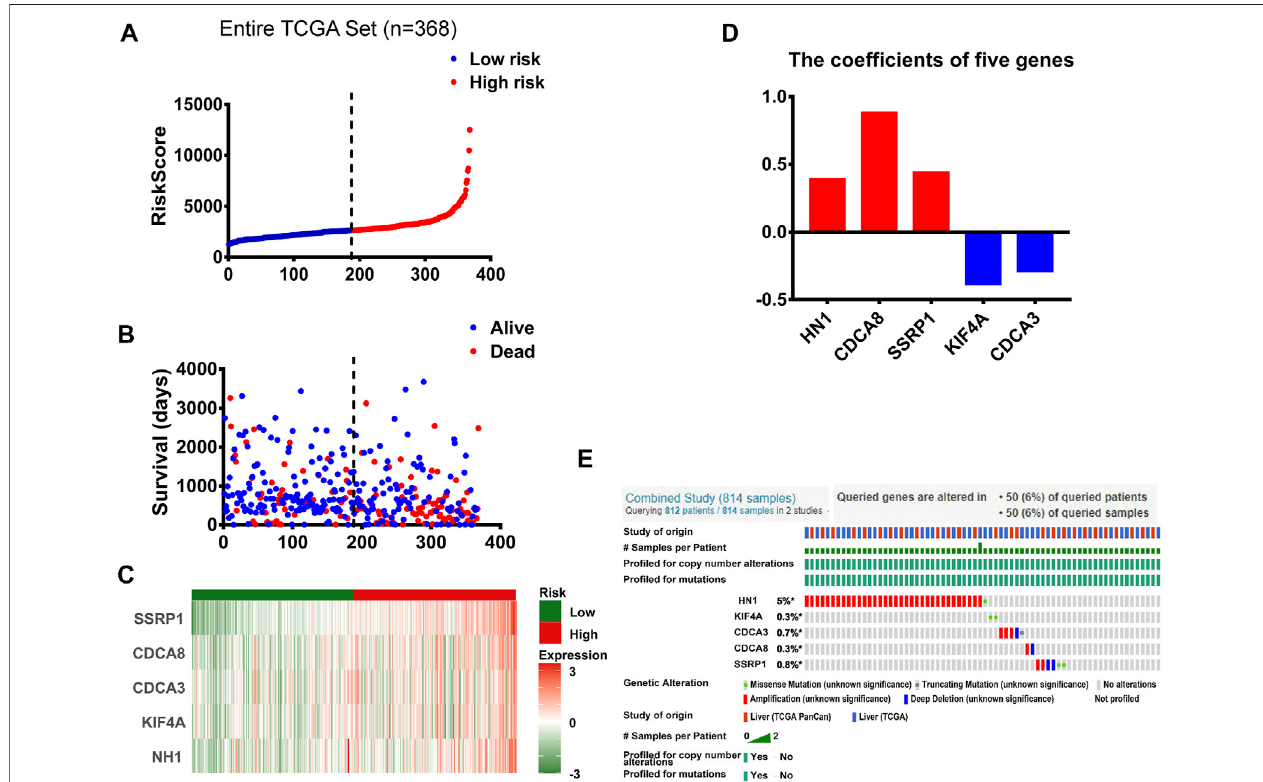
FIGURE2| ThepanelofE2Ftargetgenessignature (A) ThedistributionofriskscoresinpatientswithHCC. (B) Thesurvivaltimeandsurvivalstatusofpatientswith HCC ranked by risk scores (C) The distribution of expression of the fi ve genes in heatmap in patients with HCC ranked by risk scores. (D) The coef fi cients of fi ve genes. (E) Genetic alterations of fi ve E2F target genes from TCGA PanCan and TCGA in patients with hepatocellular